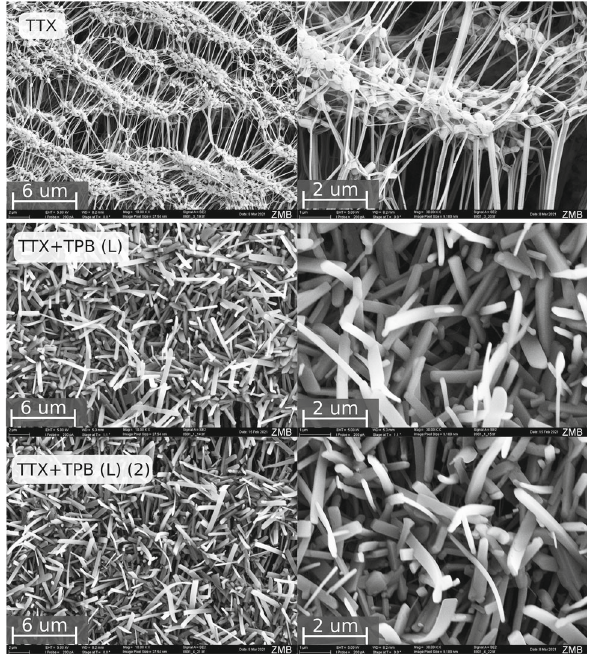
Fig. 17 SEM images of TTX, and TTX+TPB (L) before and after (2) immersion in LAr. The scale bars of the figures on the left and right are 6 and 2 µ m